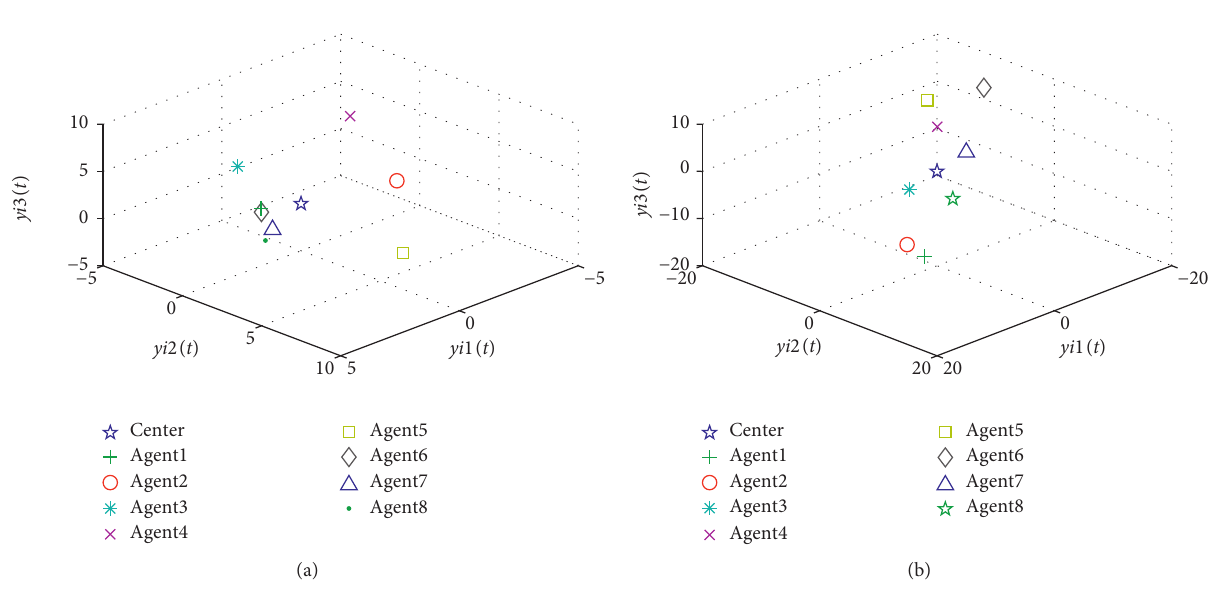
Figure 2: Output snapshots of eight agents without the robust compensator. (a) t � 0 s. (b) t � 10 s.